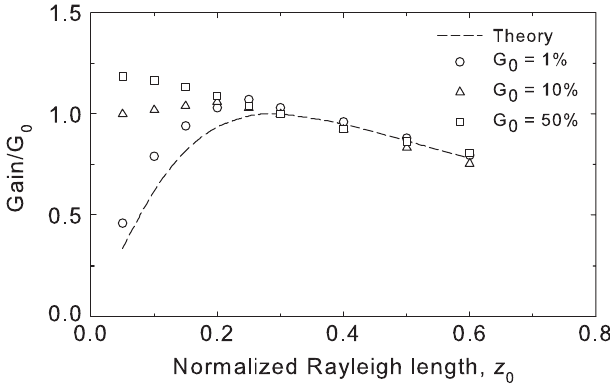
FIG. 1. Simulations of weak-field gain versus normalized z 0 for increasing values of G 0 . The dashed curve is the gain predicted by Eq.